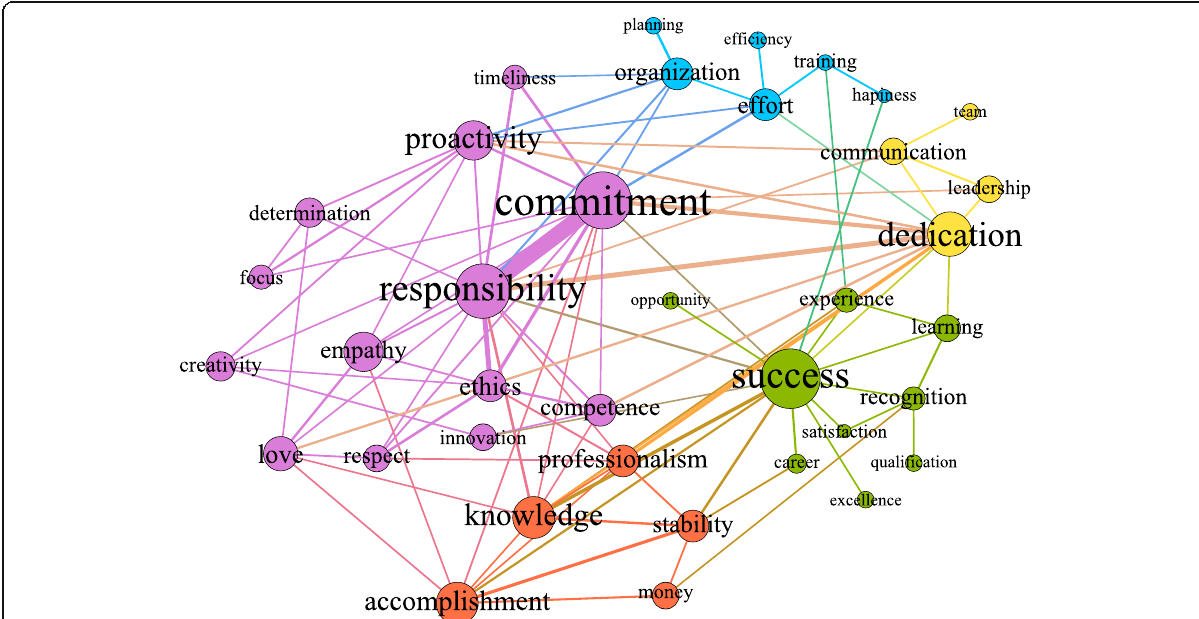
Fig. 2 Semantic network of professional identity for the group of undergraduate students who do not work. Notes. The colors of the connections between the words represent the communities; the size of the nodes is proportional to their centralities of intermediation, and the thickness of the edges is proportional to the value of the IF index